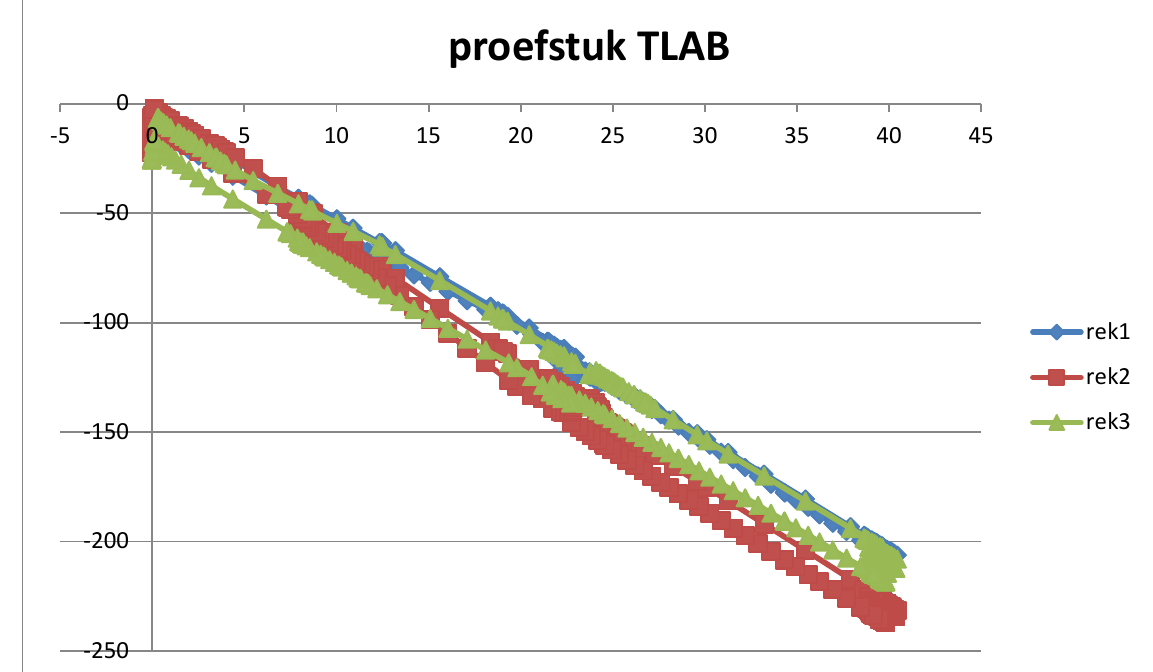
Fig. 16 The strain (vertical axis) recorded by three strain gauges plotted against force (horizontal axis) recorded by the force